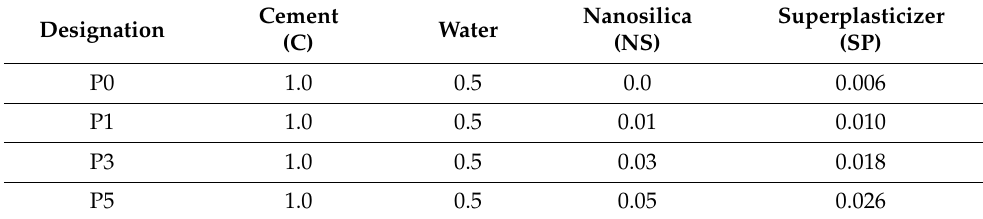
Table 3. Proportions of the cement pastes.